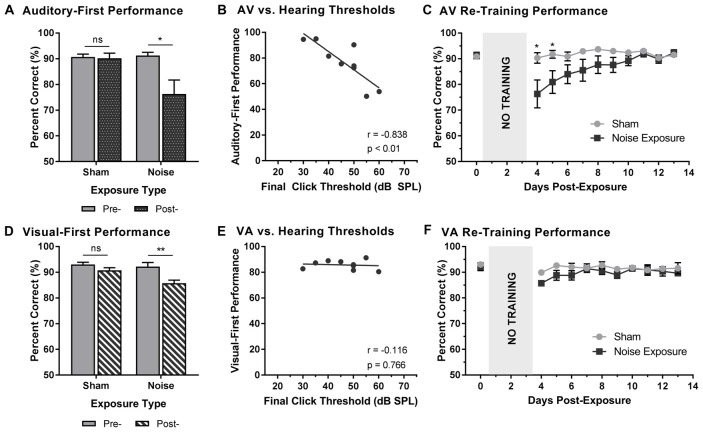
Altered auditory- and visual-first performance during TOJ training sessions following noise exposure. (A) Auditory-first performance and (D) visual-first performance pre- and 3 days post-exposure to a loud noise or sham. Following noise exposure there was a slight decrease in auditory-first performance (*p < 0.05, ns = not significant), as well as a significant decrease in visual-first performance (**p < 0.02, ns = not significant). Solid bars represent pre-exposure performance, and patterned bars represent post-exposure performance. Correlation results for (B) auditory-first performance and (E) visual-first performance as a function of final hearing sensitivity (i.e., click thresholds). Gray circles represent the individual data for each rat post-noise exposure. The solid line represents the linear regression line, and the Pearson correlation results along with the significance levels are displayed in the bottom of the panel. Behavioral performance on (C) auditory-first trials and (F) visual-first trials were monitored for 10 days post-exposure. A decrease in performance on auditory-first trials was observed following noise exposure during the first two training sessions (*p < 0.05). Results are displayed as mean ± SEM, n = 9.